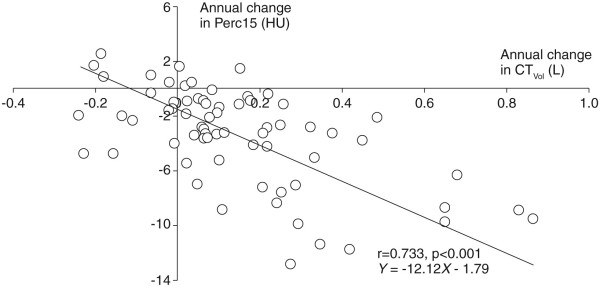
Correlation and regression of annual change in CTVol with annual change in Perc15.